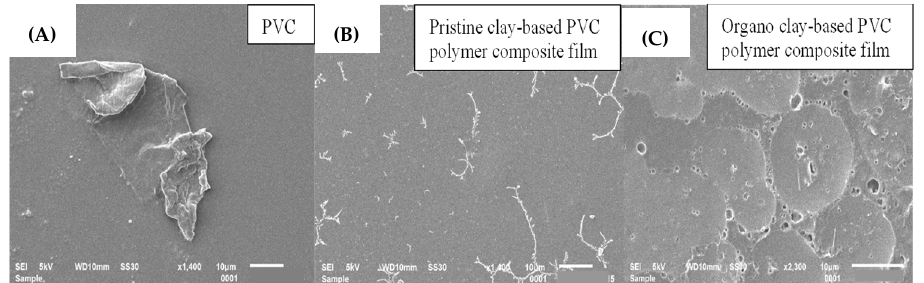
Figure 10. SEM images of ( A ) pure PVC polymer film, ( B ) clay-based PVC polymer composite film and ( C ) organo-clay-based PVC polymer composite film.